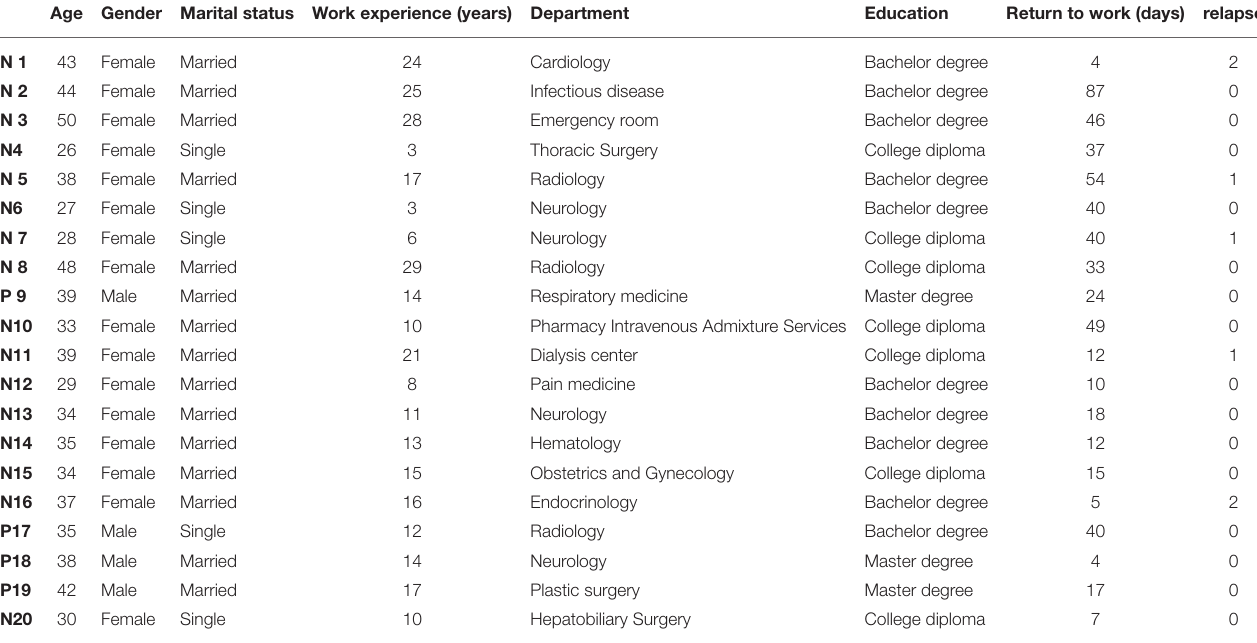
TABLE 1 | Characteristics of